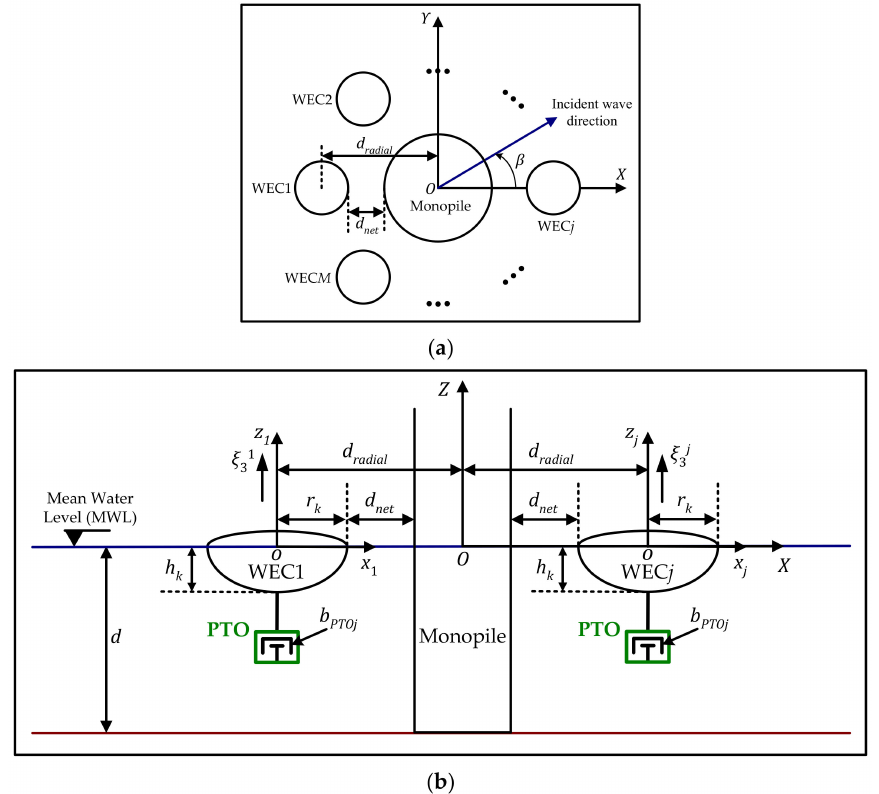
Figure 2. Geometry of the examined problem and definition of basic quantities: ( a ) X − Y plane; ( b ) X − Z plane.